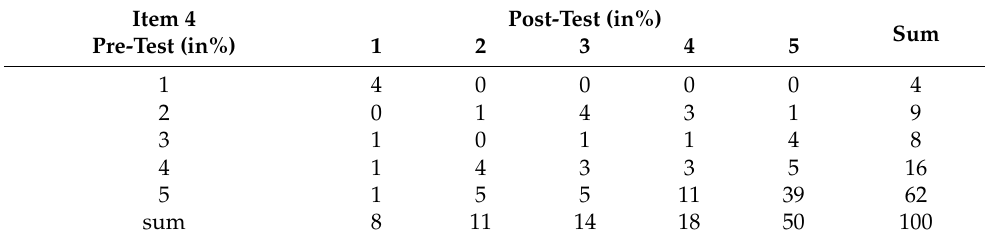
Table 4. Contingency table of answers to question no. 4 (in%). Item 4